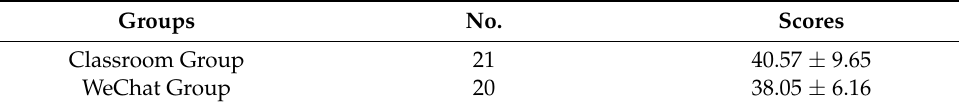
Table 4. Self-efficacy questionnaire scores (N = 41).